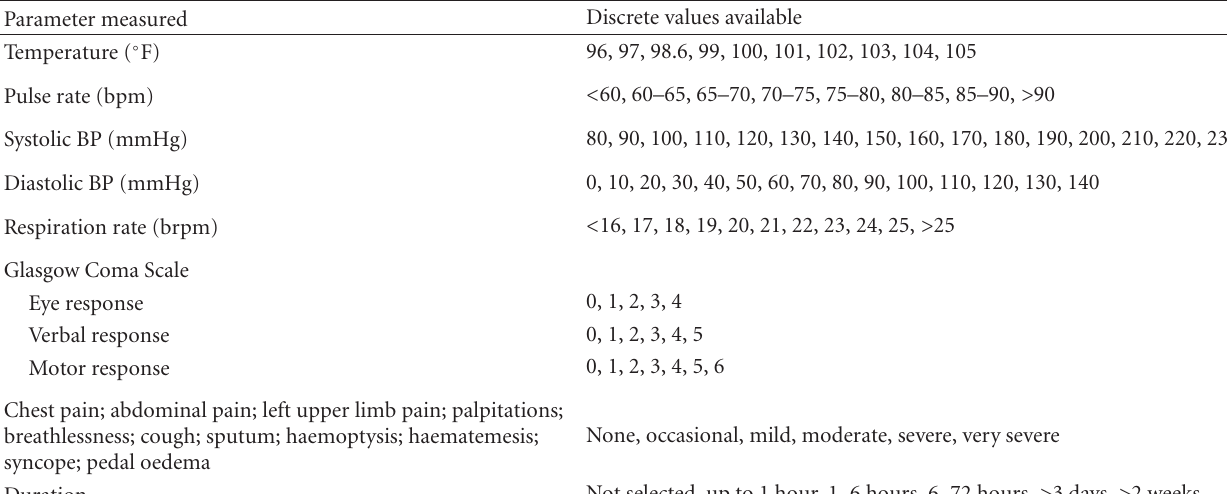
Table 2: Patient spreadsheet measurements for cardiac